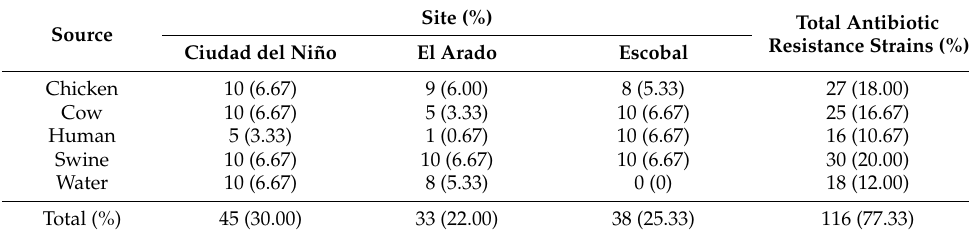
Table 1. Total antibiotic-resistant strains by source and sampling